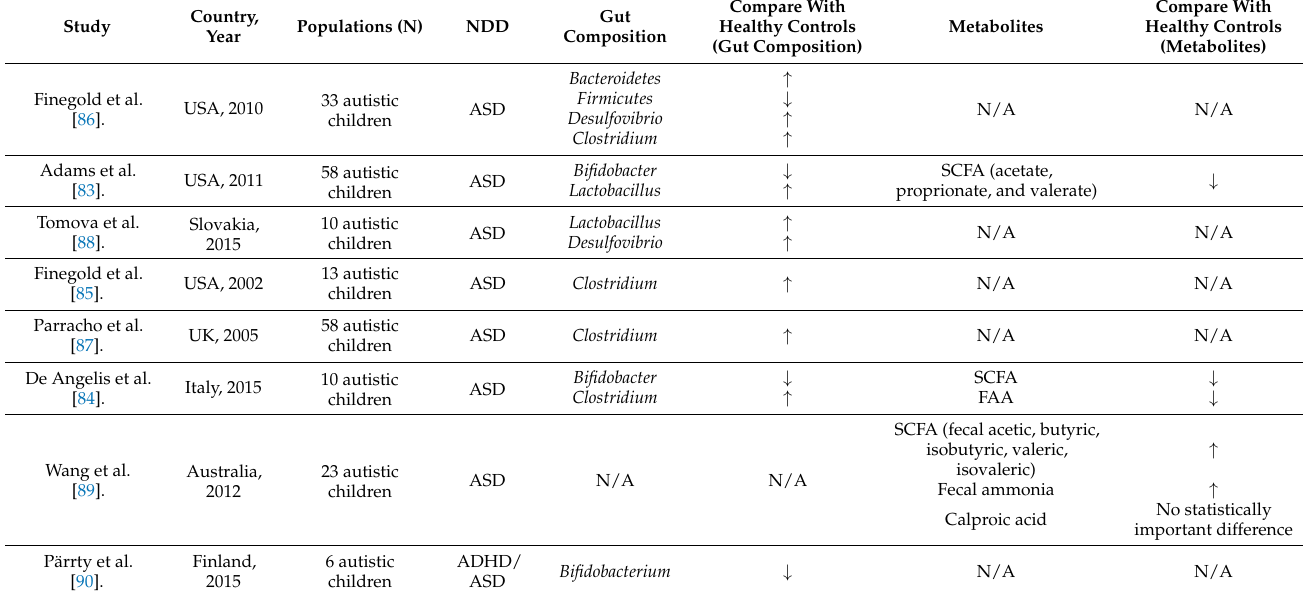
Table 1. Bacterial composition differences in gut microbiota of people with NDDs (ASD, ADHD) compared with healthy controls, and their respective metabolite changes (when applicable) (NDDs: neurodevelopmental disorders, ASD: autism spectrum disorder, ADHD: attention deficit hyperactiv- ity disorder, SCFA: short-chain fatty acid, FAA: free amino acids N/A: not applicable, ↑ :